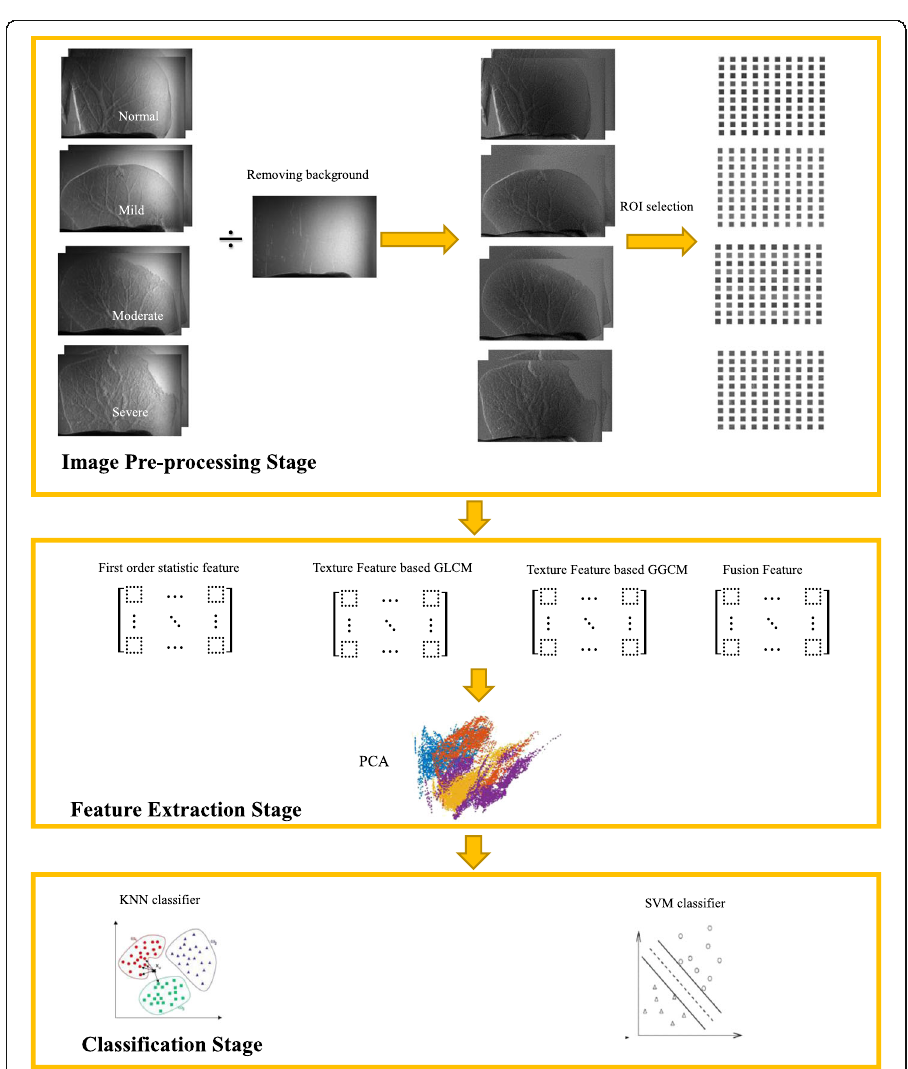
Fig. 2 The procedures of the fibrosis classification GLCM describes the distribution of co-occurring pixel values at a given offset and re- flects the relationship between the neighbor pixels. The gray level of ROI images is re- duced to 32 bits to save the computation time. The matrices of GLCM are calculated symmetrically at 0, 45, 90, and 135° with 1-pixel distance and normalized thereafter. For one ROI image, four GLCMs are obtained. Nine features including angular second moment (energy), inertia, inverse, difference moment, entropy, sum average, difference average, sum entropy, and difference average are extracted from each GLCM matrix.